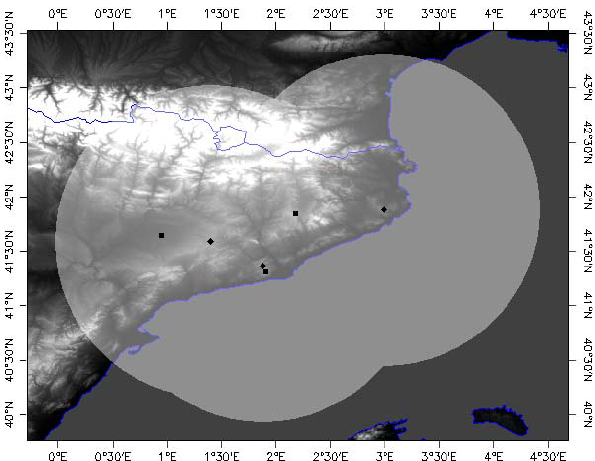
Fig. 1. Three dimensional radar coverage considered in this study. Radar (XRAD) and lightning (XDDE) sensor locations are marked, respectively, with diamond and square symbols.